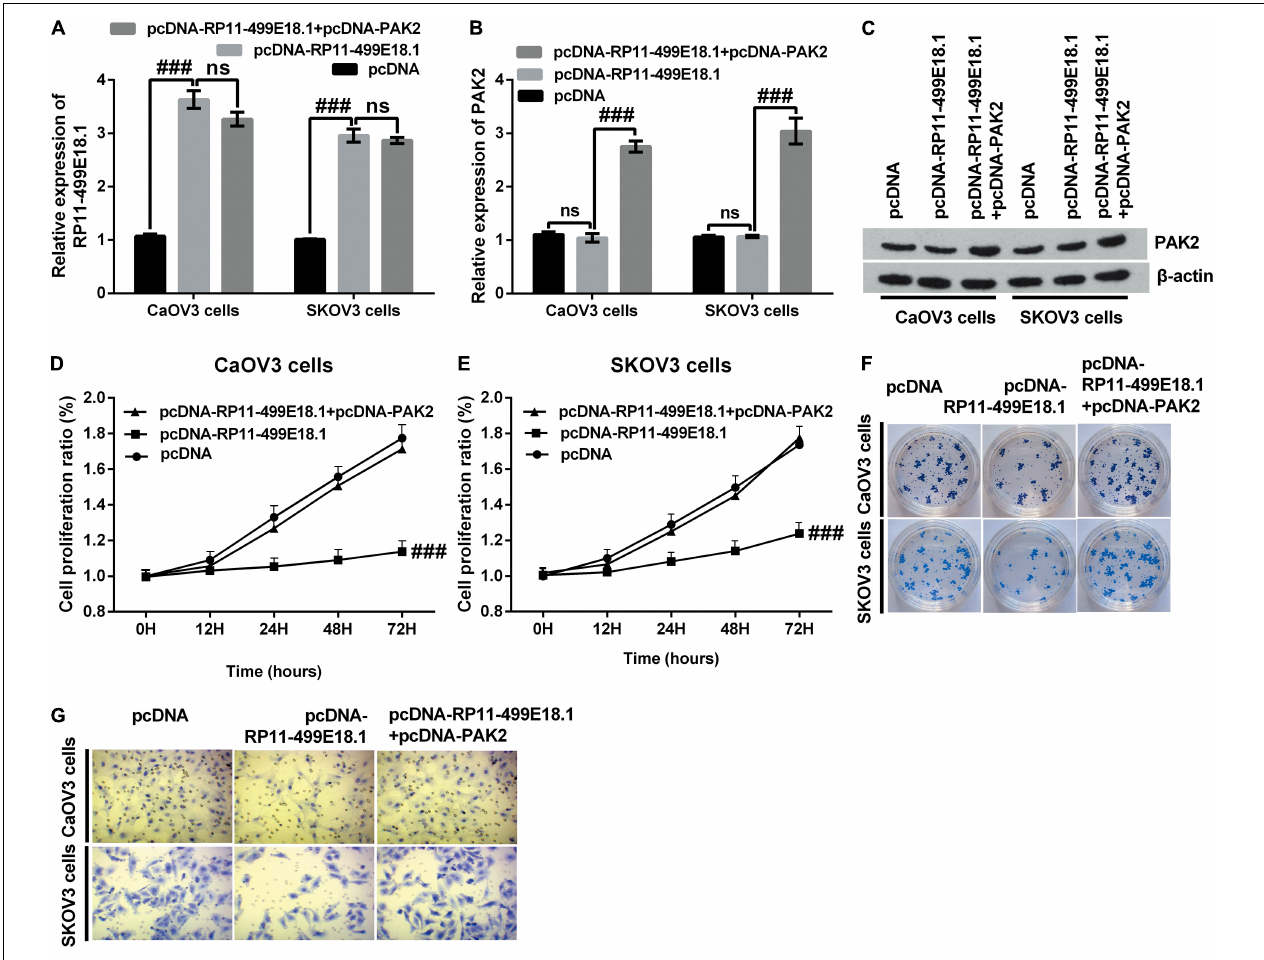
FIGURE 5 | PAK2 upregulation notably counteracted RP11-499E18.1 overexpression-triggered tumor-suppressing effects. The plasmids pcDNA3.1, pcDNA-RP11-499E18.1, and pcDNA-RP11-499E18.1 + pcDNA-PAK2 were respectively transfected into CaOV3 and SKOV3 cells. (A) RP11-499E18.1 was successfully overexpressed in CaOV3 and SKOV3 cells. (B,C) PAK2 was successfully overexpressed in CaOV3 and SKOV3 cells. (D–G) PAK2 overexpression distinctly counteracted RP11-499E18.1 overexpression-triggered suppressing effects on the proliferation, colony formation, and migration of CaOV3 and SKOV3 cells. PAK2, P21 (RAC1) activated kinase 2. ### p < 0.001, ns, no